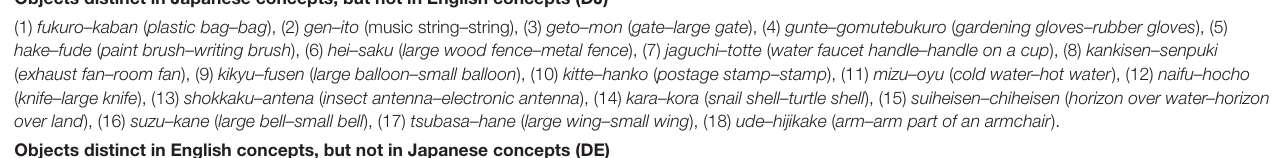
TABLE 1 | List of paired objects. Objects distinct in Japanese concepts, but not in English concepts (DJ) (1) fukuro–kaban ( plastic bag–bag ), (2) gen–ito (music string–string), (3) geto–mon ( gate–large gate ), (4) gunte–gomutebukuro ( gardening gloves–rubber gloves ), (5) hake–fude ( paint brush–writing brush ), (6) hei–saku ( large wood fence–metal fence ), (7) jaguchi–totte ( water faucet handle–handle on a cup ), (8) kankisen–senpuki ( exhaust fan–room fan ), (9) kikyu–fusen ( large balloon–small balloon ), (10) kitte–hanko ( postage stamp–stamp ), (11) mizu–oyu ( cold water–hot water ), (12) naifu–hocho ( knife–large knife ), (13) shokkaku–antena ( insect antenna–electronic antenna ), (14) kara–kora ( snail shell–turtle shell ), (15) suiheisen–chiheisen ( horizon over water–horizon over land ), (16) suzu–kane ( large bell–small bell ), (17) tsubasa–hane ( large wing–small wing ), (18) ude–hijikake ( arm–arm part of an armchair ). Objects distinct in English concepts, but not in Japanese concepts (DE) (1) beak–bill ( kuchibashi–kuchibashi ), (2) beans–peas ( mame–mame ), (3) breadcrust–ear ( mimi–mimi ), (4) bubbles–foam ( awa–awa ), (5) chair–stool ( isu–isu ), (6) crab claw–scissors ( hasami–hasami ), (7) fang–tusk ( kiba–kiba ), (8) clock hand–needle ( hari–hari ), (9) horns–antlers ( tsuno–tsuno ), (10) mouse–rat ( nezumi–nezumi ), (11) mustache–beard ( hige–hig e), (12) fingernail–claw ( tsume–tsume ), (13) thumb–big toe ( oyayubi–oyayubi ), (14) trunk–nose ( hana–hana ), (15) watch–clock ( tokei–tokei ), (16) web–nest ( su–su